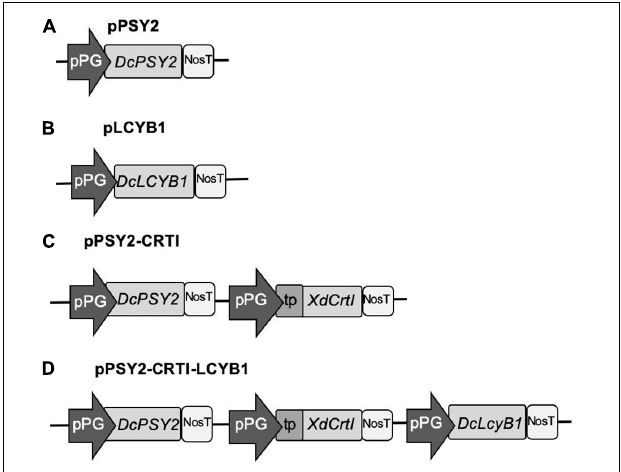
FIGURE 2 | pCP-CG constructs used for the functional assessment of DcPSY2, DcLCYB1, and XdCRTI. The pCP backbone is derived from pB7FWG2.0, with the incorporation of a specifically designed Multiple Cloning Site (MCS; see Supplementary Figure 1 ). Different carotenogenic genes were cloned into the MCS, under the control of the tomato polygalacturonase promoter (pPG) and the Nos terminator (NosT). (A) pPSY2. The single gene and fruit-specific expression cassette PG:DcPSY2 was chemically synthesized and cloned into pCP. (B) pLCYB1. The single gene and fruit-specific expression cassette PG:DcLCYB2 was chemically synthesized and cloned into pCP. (C) pPSY2-CRTI. A double gene and fruit-specific expression cassette including the PG promoter driving the XdCRTI gene fused to a transit peptide (PG:tpXdCRTI) was chemically synthesized and cloned into pPSY2. (D) pPSY2-CRTI-LCYB1. The single gene and fruit-specific expression cassette PG:DcLCYB2 was cloned into